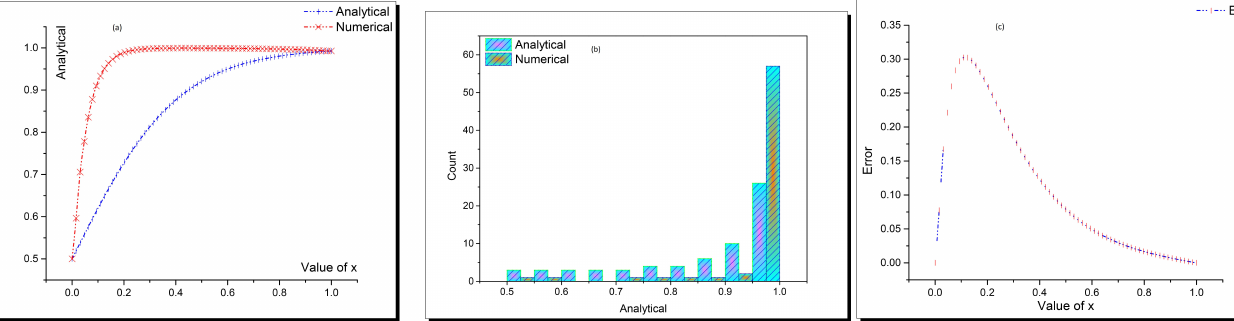
Figure 5. Two-dimensional plot ( a ), double y-column plot ( b ) for the matching between obtained analytical and numerical solutions, and two-dimensional plot of the absolute error ( c ) for Equation (3) with respect to Table 1.